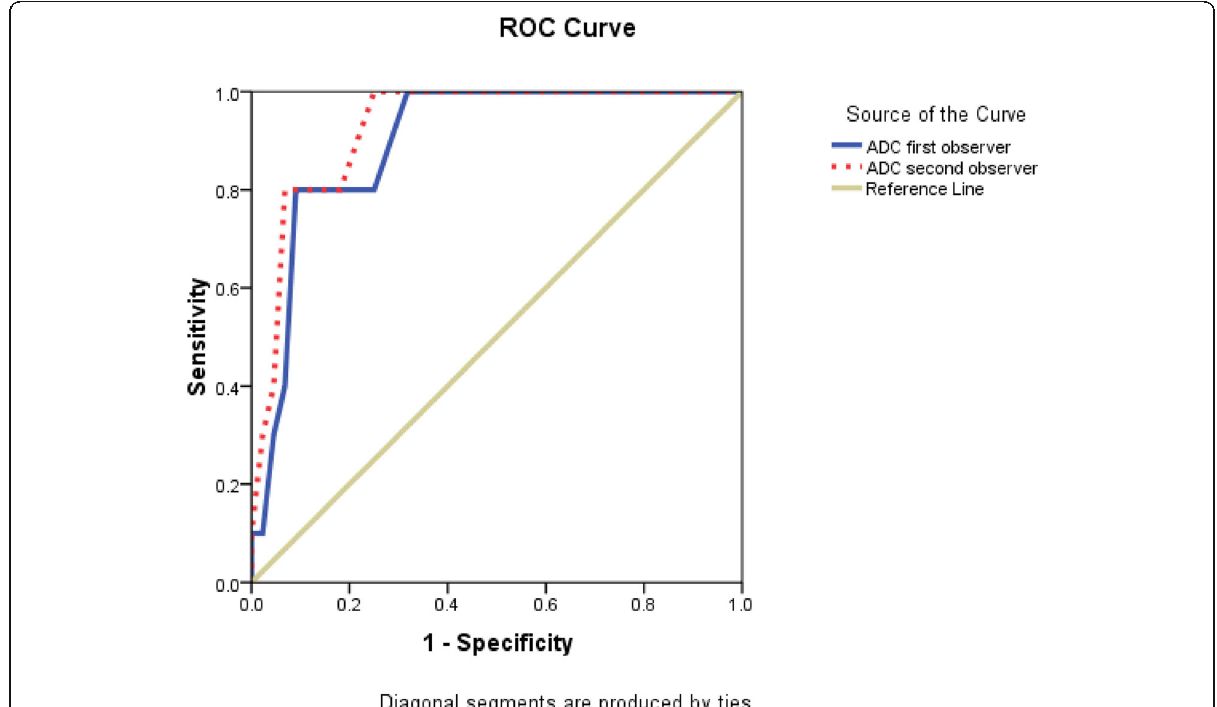
Fig. 5 ROC curve for the cutoff ADC between recurrent breast carcinoma and benign post-operative changes by observer one and two. A cutoff ADC value of 1 × 10 – 3 mm 2 /s for observer one had 80% sensitivity, 90.9% specificity, 66.7% PPV, 95.2% NPV, and 88.9% accuracy in diagnosis of recurrent breast carcinoma. For observer two, a cutoff ADC value of 1.25 × 10 – 3 mm 2 /s had sensitivity of 80%, specificity of 88.6%, PPV of 61.5%, NPV of 95.2%, and diagnostic accuracy of 87.03% in differentiating recurrent breast carcinoma from benign post-operative